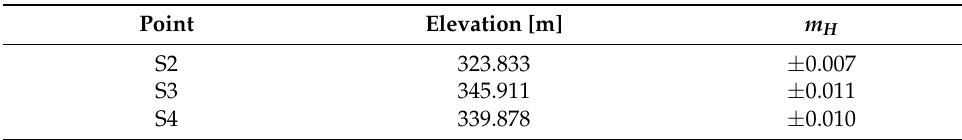
Table A7. Transformation parameters.